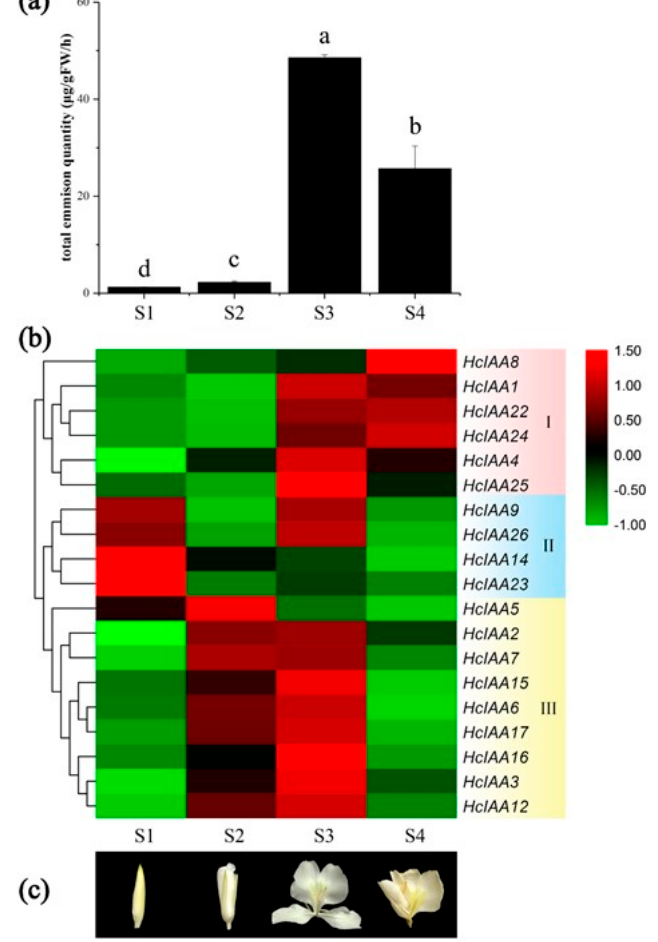
Figure 6. Heat map of the expression of HcIAA genes during different flower developmental stages. ( a ) The amount of floral volatiles emitted during developmental stages (S1, S2, S3 and S4). ( b ) The hierarchically clustered heat map was constructed with the relative expression qRT-PCR data for 19 HcIAA genes (indicated on the right) in four development stages (shown at the down). Levels of downregulated expression (green) or upregulated expression (red) are shown on a log 2 scale from the highest to the lowest expression for each HcIAA gene. ( c ) Different flower developmental stages are shown as pictures.